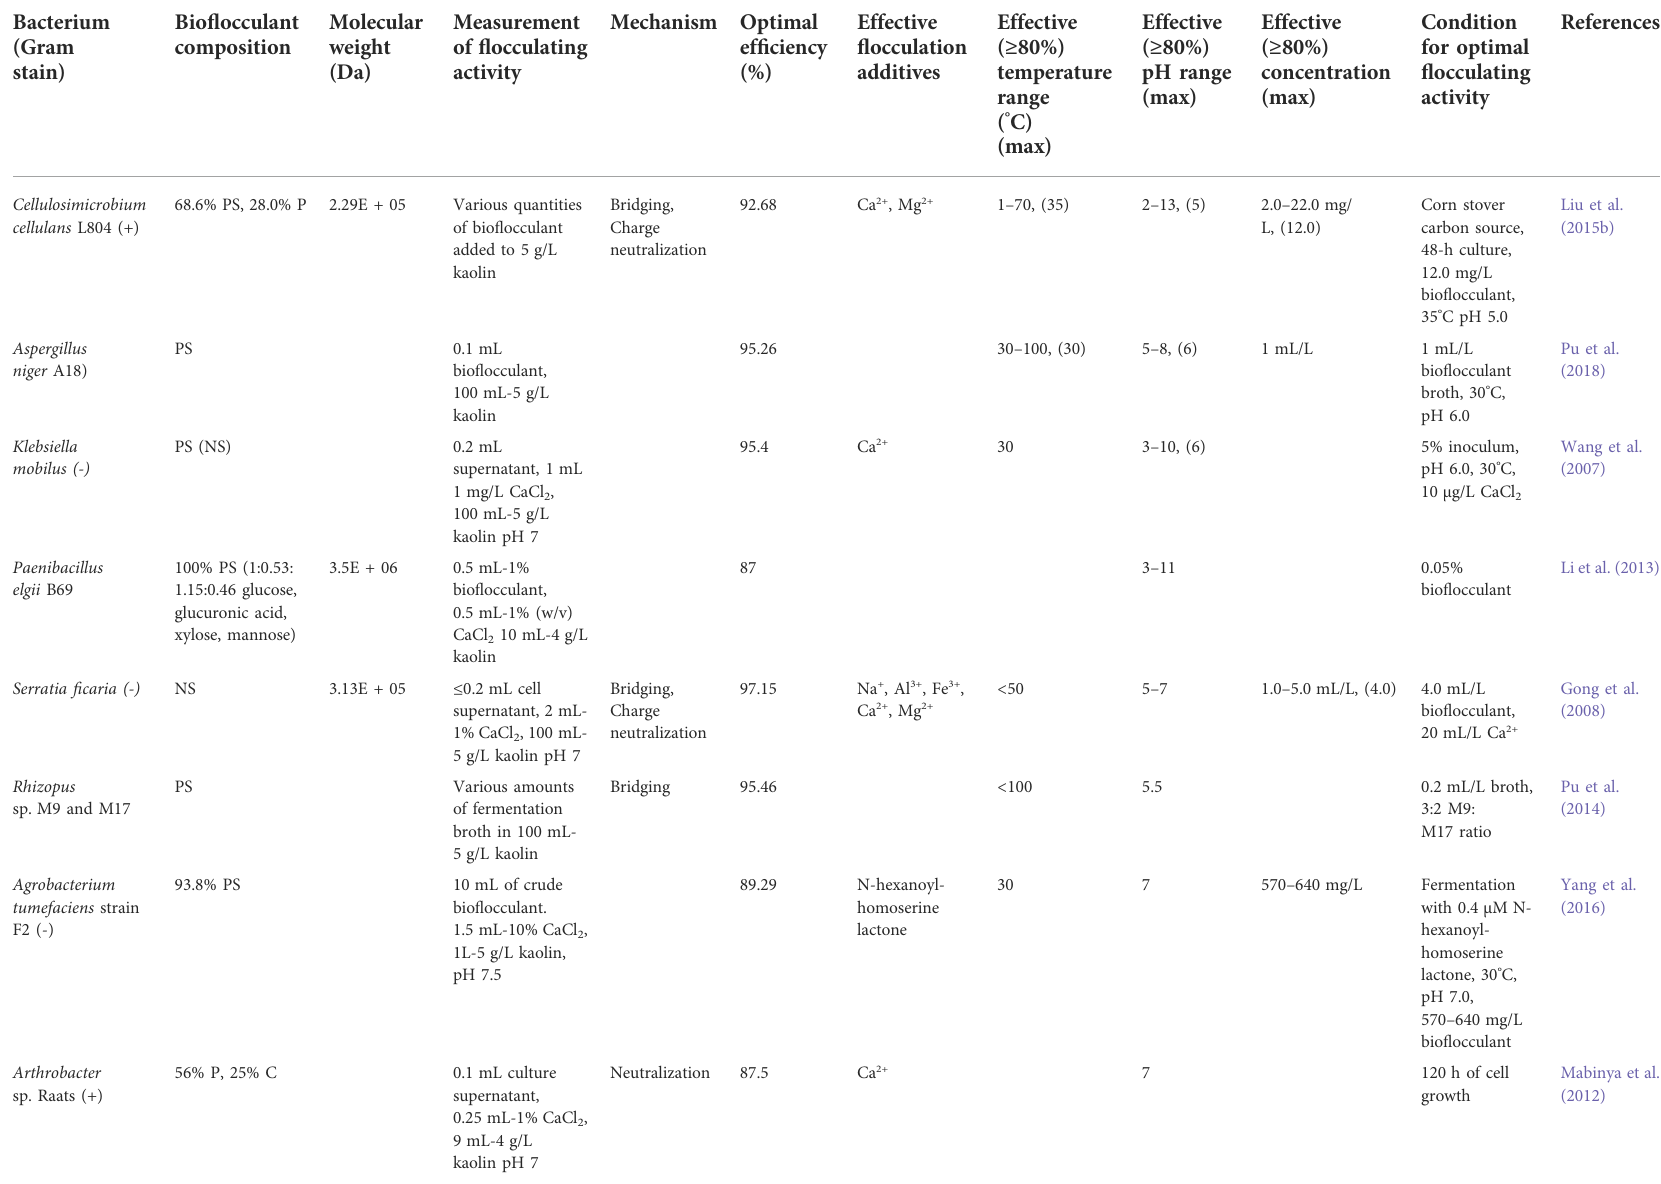
TABLE 6 Soil bacteria and fungi and their fl occulation